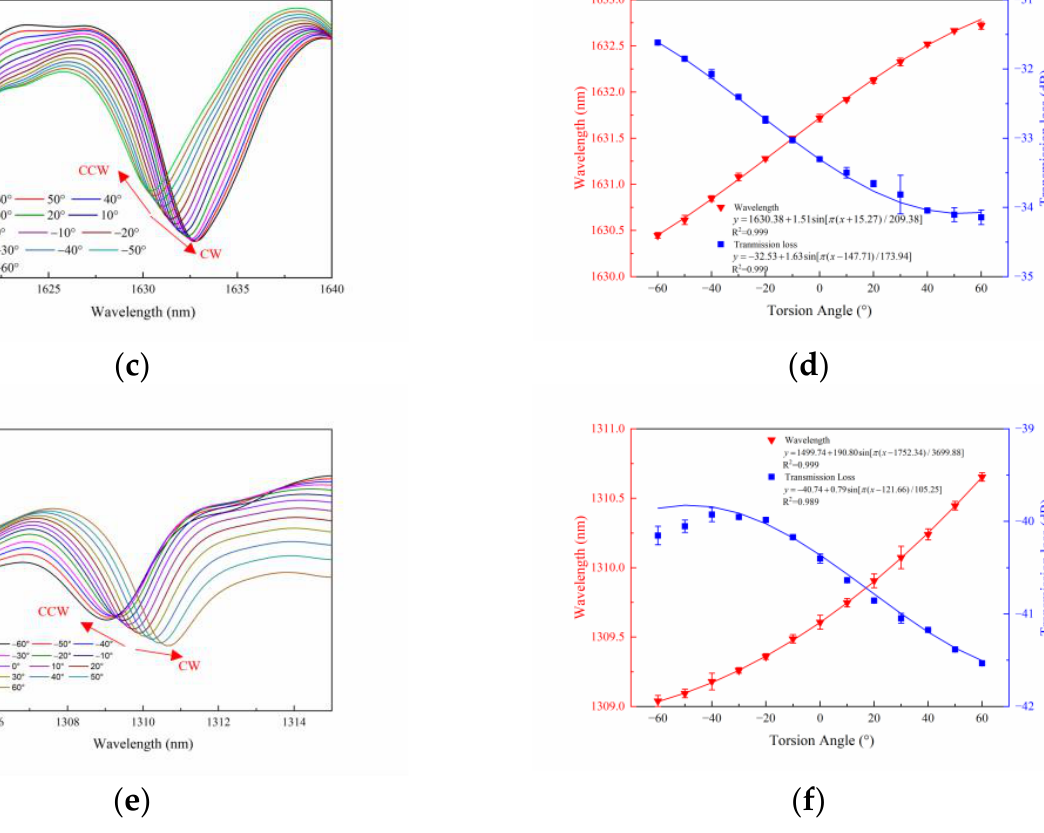
Figure 5. The response and wavelength fitting of the sensor structure about torsion with the pre-twist angles of 180 degrees ( a , b ), 360 degrees ( c , d ), and 540 degrees ( e , f ). In general, the maximum wavelength sensitivities are 0.242 nm/(rad/m), 0.161 nm/(rad/m), and 0.105 nm/(rad/m), and the corresponding power sensitivities are − 0.04 dB/ ◦ , − 0.02 dB/ ◦ and − 0.02 dB/ ◦ , as shown in Figure 5b,d,f, respectively. Comparing the experimental re- sults of the three HTCF structures, we can find that the maximum wavelength sensitivity is obtained when the pre-twist angle is 180 degrees. It should be noted that a greater pre-twist angle will result in increased losses. The length of the fiber is fixed at 0.3 cm; the larger the pre-twist angle, the faster the guide mode energy loss in the fiber, resulting in the decrease in interference spectrum energy and the increase in sensor loss, which is not conducive to sensing applications. This can be intuitively seen from Figure